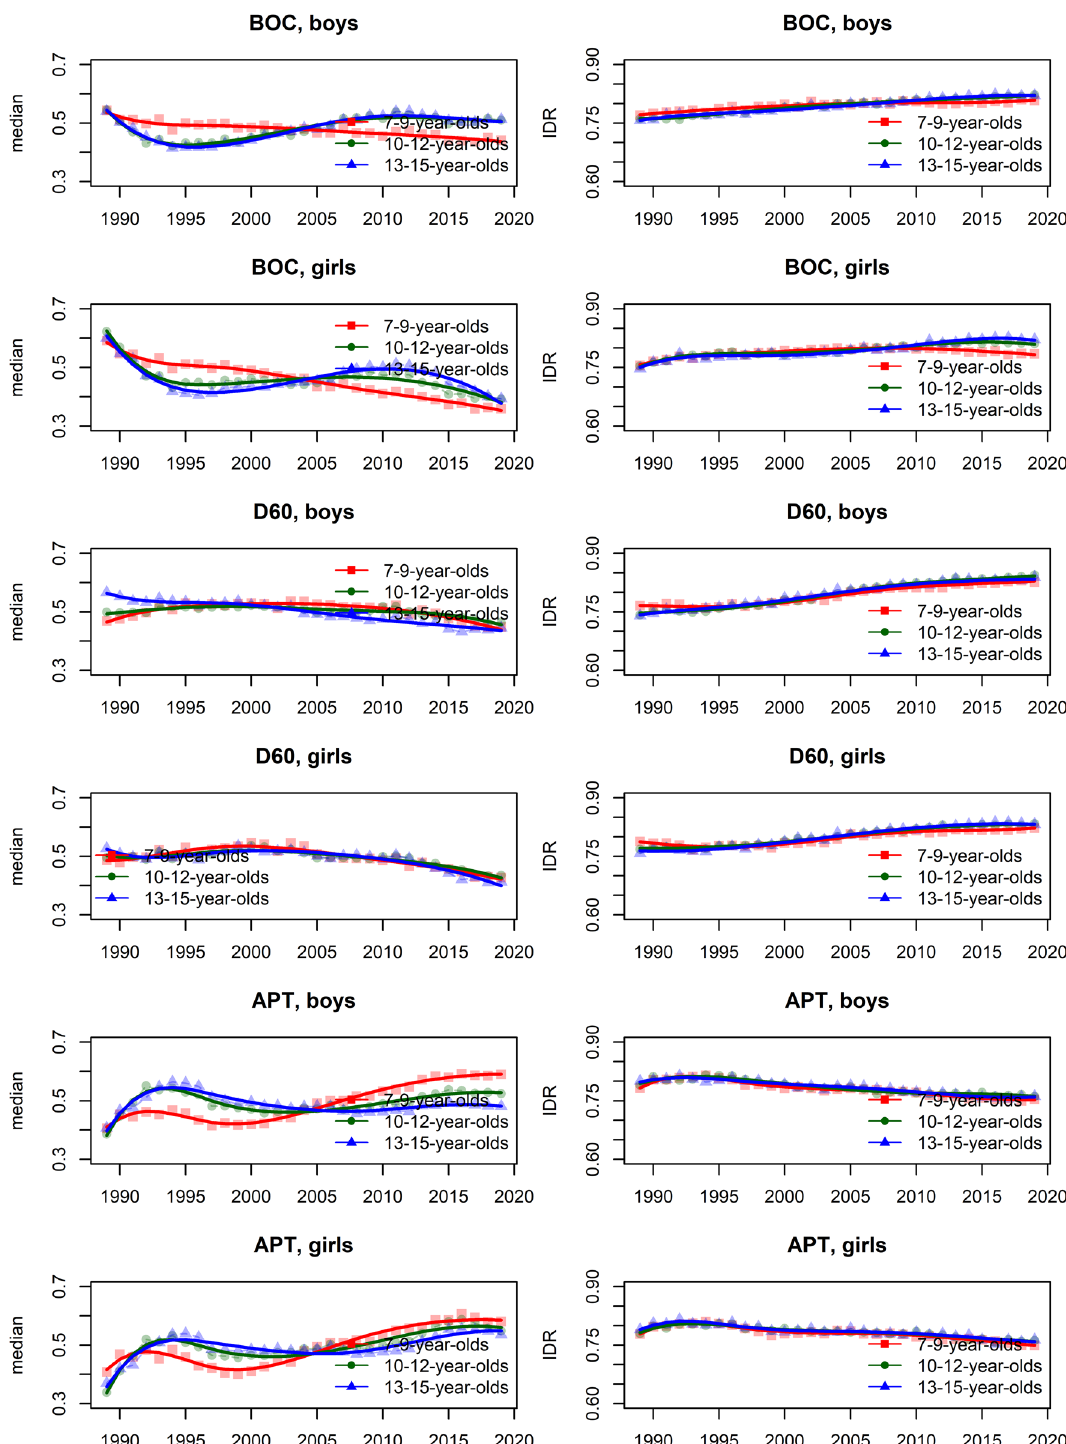
Figure 5. Time trends (medians and IDR) in the BOC, D60, and APT between 1989 and 2019 by gender, across three age groups: 7–9 years, 10–12 years, and 13–15 years. Points and solid lines are the estimated values and smoothed estimated values, respectively, adjusted by region (the results are shown fixing the region to its mode). In the plots for BOC and D60 showing the estimated medians, the estimates below (above) 1/2 imply that the results were better (worse) than in the period 1989–2019 when comparing children of the same gender and age; for APT the opposite holds. See Supplementary Information for more results including the uncertainty in the point